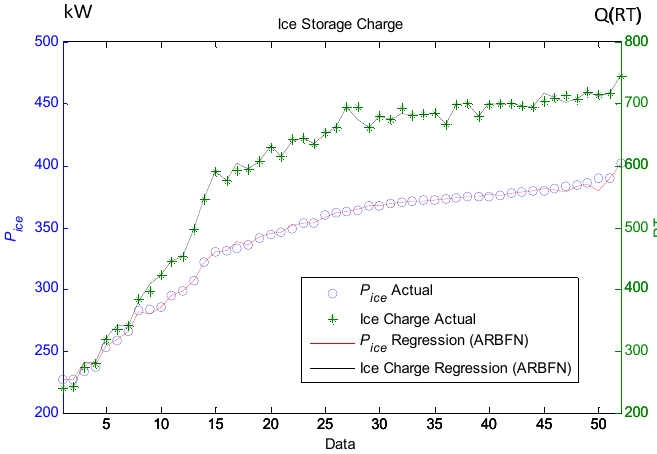
Figure 5. Charge process net.